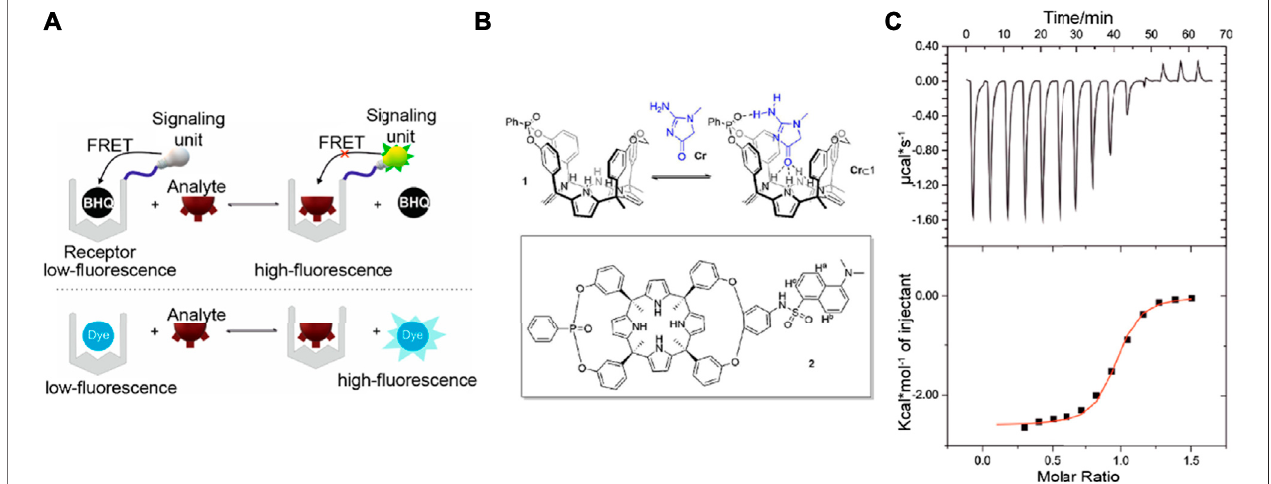
FIGURE 5 | (A) Schematic showing the supramolecular fl uorescence-based approach towards detecting creatinine. BHQ: a black-hole quencher (B) Top: Interactionofcreatininewithacalix[4]pyrrolerecognitionunit.Bottom:Calix[4]pyrrolereceptorismodi fi edwithdansyl fl uorophore. (C) Top:Heatvs.timerawdataforthe calorimetry titration of the lipophilic creatinine derivative. Bottom: Normalized and integrated data from (C) top, showing the fi t to the one-site binding model. Figures adapted from (Sierra et al., 2020). Copyright 2020 American Chemical Society.